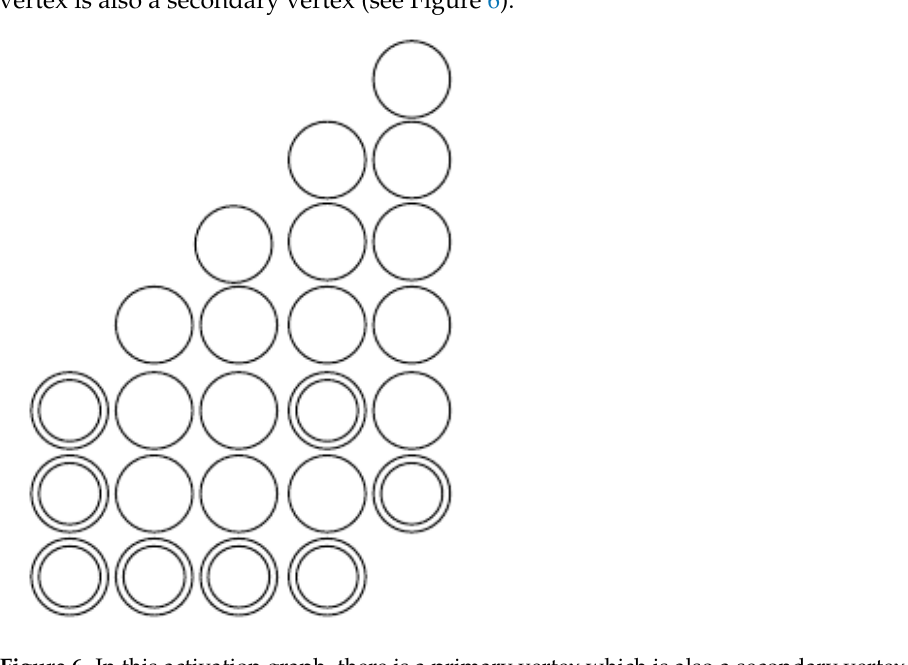
Figure 6. In this activation graph, there is a primary vertex which is also a secondary vertex. An activation diagram C is connected if the secondary vertices of the corresponding activation graph form a connected, undirected graph. As an example, Figures 3 and 4 are connected activation diagrams. Figure 7 is not a connected activation diagram.